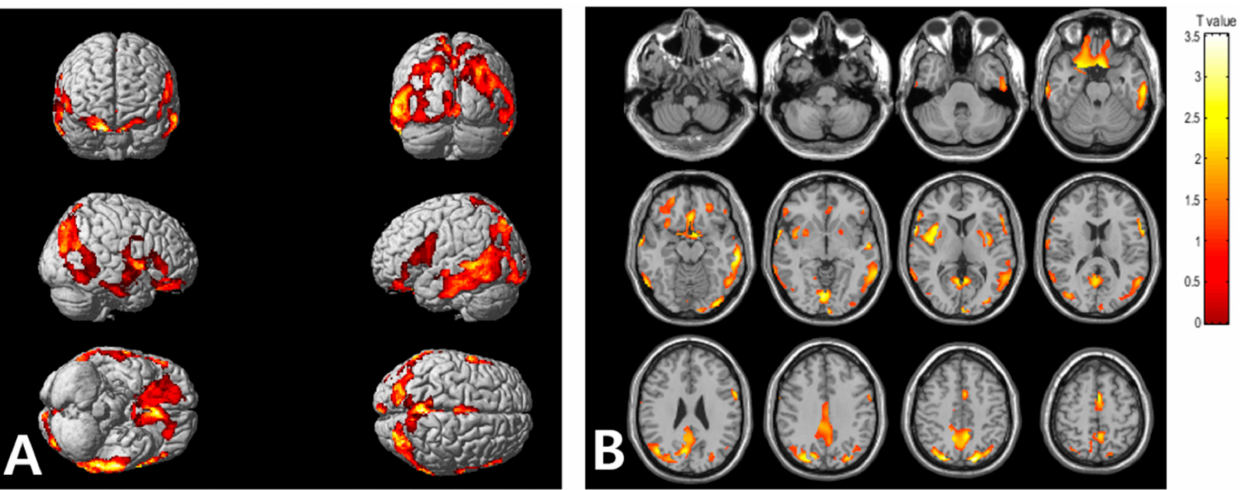
Figure 2. Voxel-based comparison of cerebral A β burden between the high and low visceral adipose tissue (VAT) metabolism groups. The statistical parameter mapping t-maps were superimposed on the volume-rendered magnetic resonance imaging (MRI) ( A ) and T1-weighted template in the axial plane ( B ) for the high VAT metabolism group > low VAT metabolism group ( p < 0.005, uncorrected at voxel-level, cluster size > 100